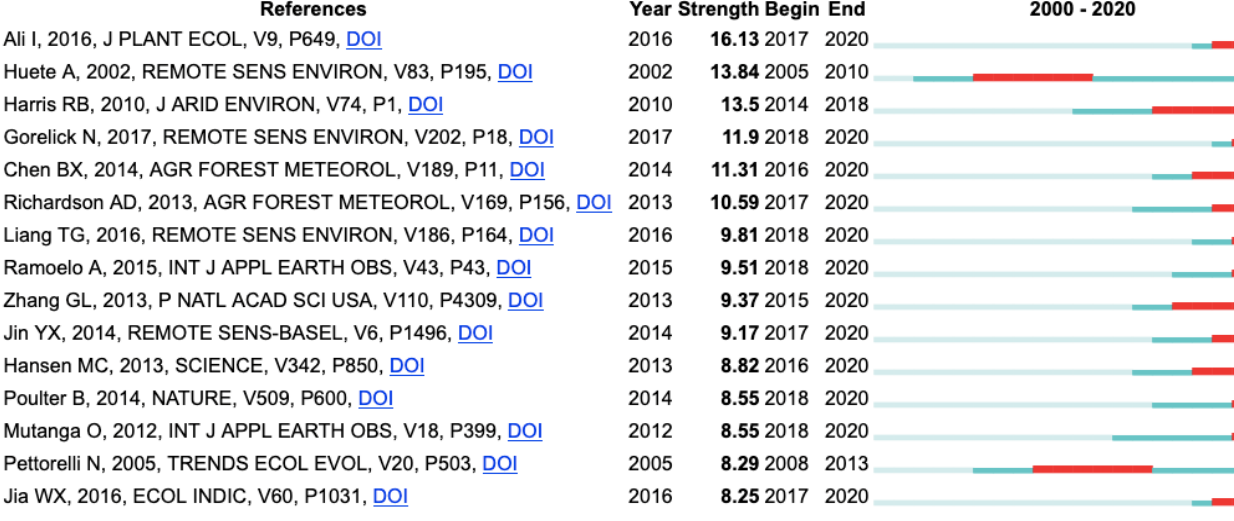
Figure 8. Top 15 references with the strongest citation bursts in GRS research. ‘V’ refers to the journal’s volume, ‘P’ refers to the document’s page. The light green line refers to ‘sustaining period’. The red line means under the timeline. The length of ‘burst’ represents ‘burst duration’.